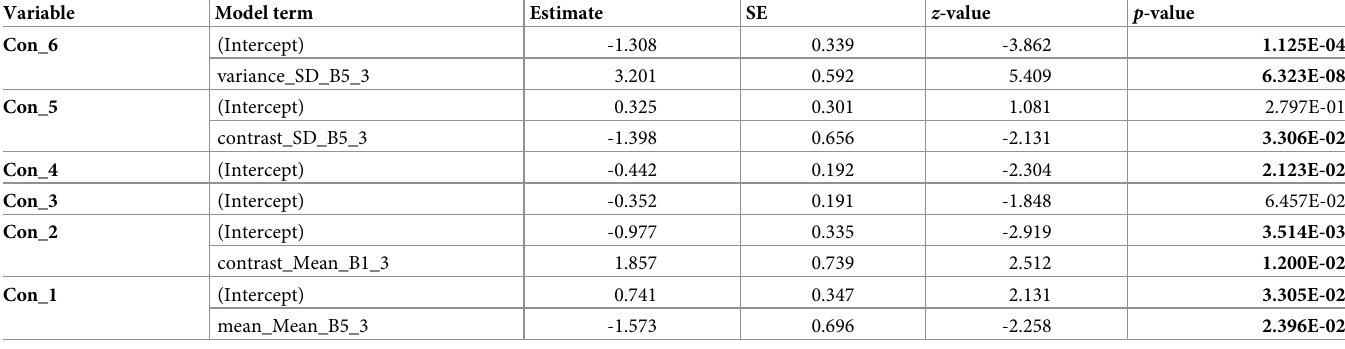
Table 8. Summary of SAT Dirichlet model regression coefficients for each of the six connectivity levels. Variable